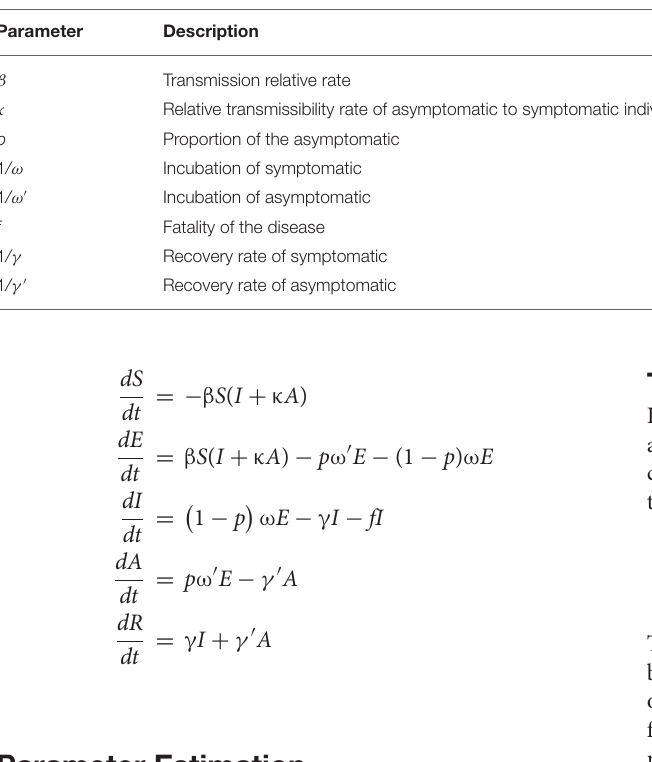
TABLE 1 | Parameter